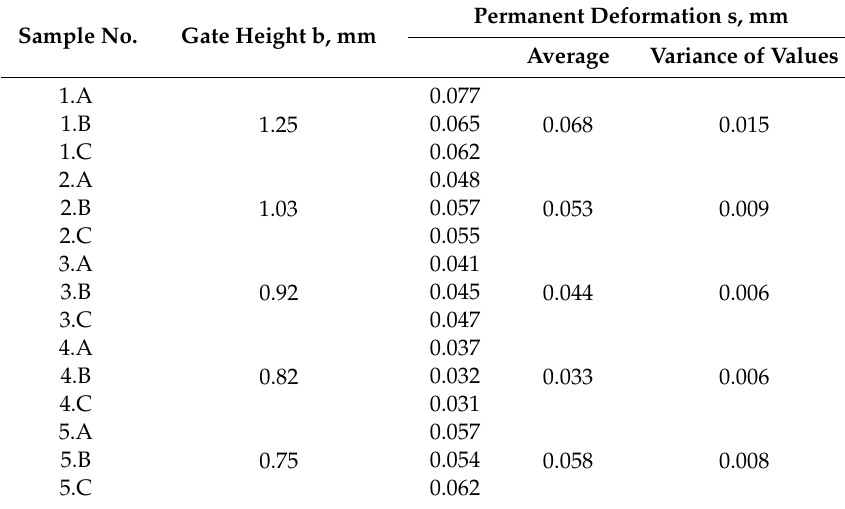
Table 4. Values of permanent deformation s.